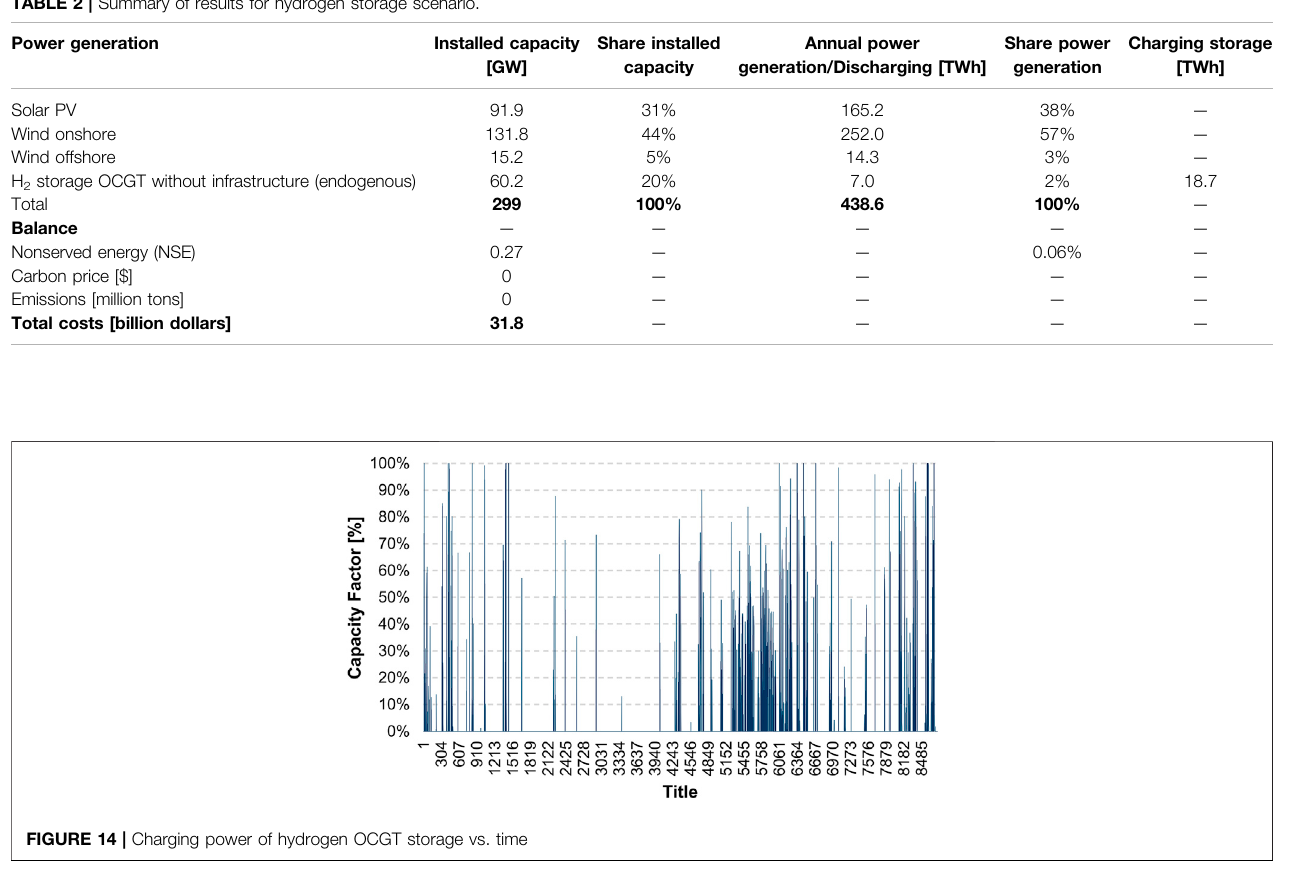
TABLE 2 | Summary of results for hydrogen storage